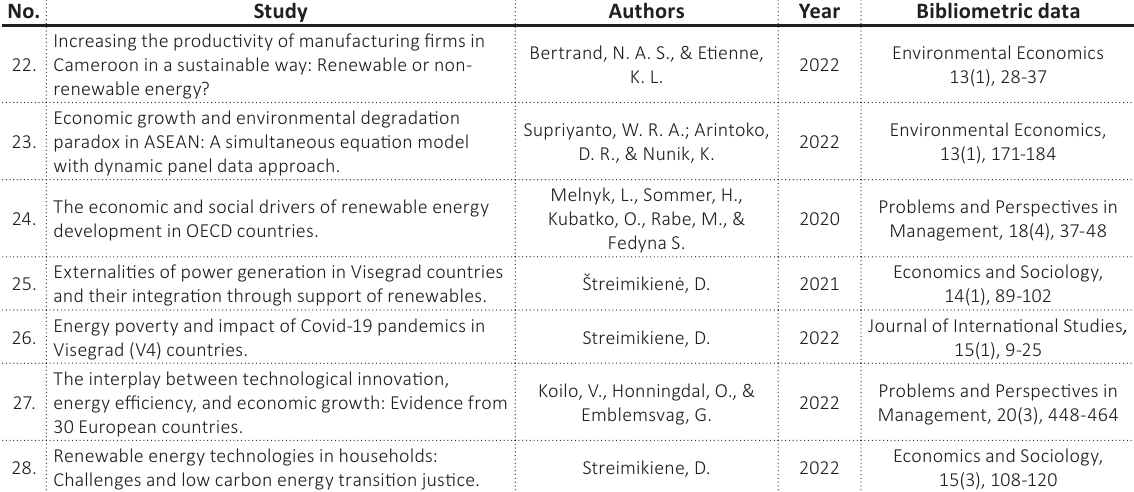
Table E1 (cont.). List of papers based on a bibliometric map of publications related to SDG 7 and Investment and SDG 7 and Responsible investment, SDG 7 and Investment